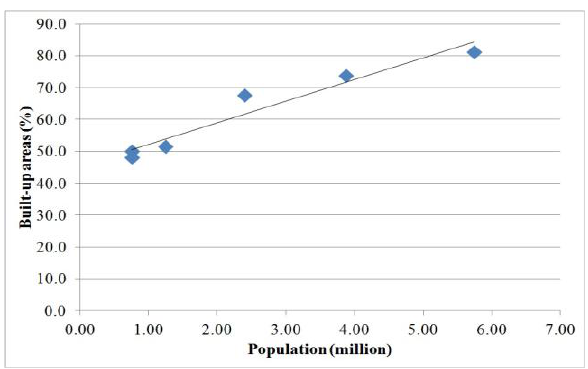
Figure 9. Relationship between the percentage of built-up areas and GDP without Edmonton and Victoria City for 2010 ( R 2 = 0.89)